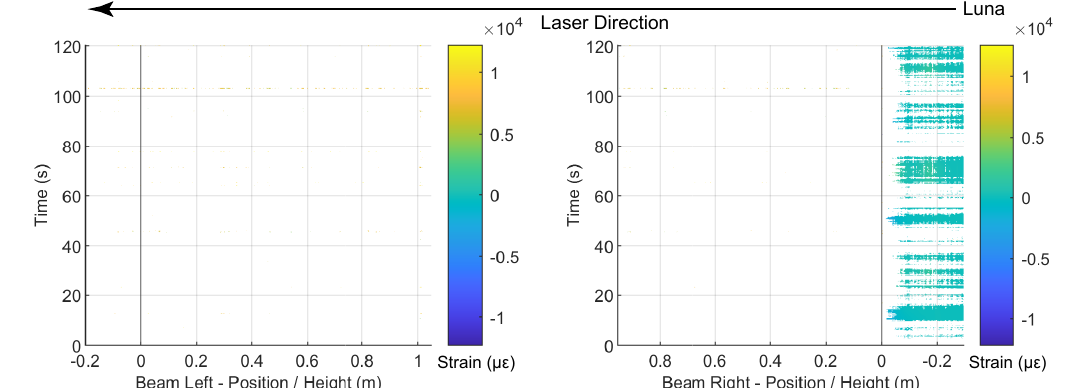
Figure 15. Contour of the fiber-optic strain measurements for PVC cable at a drift level of 1.76%.